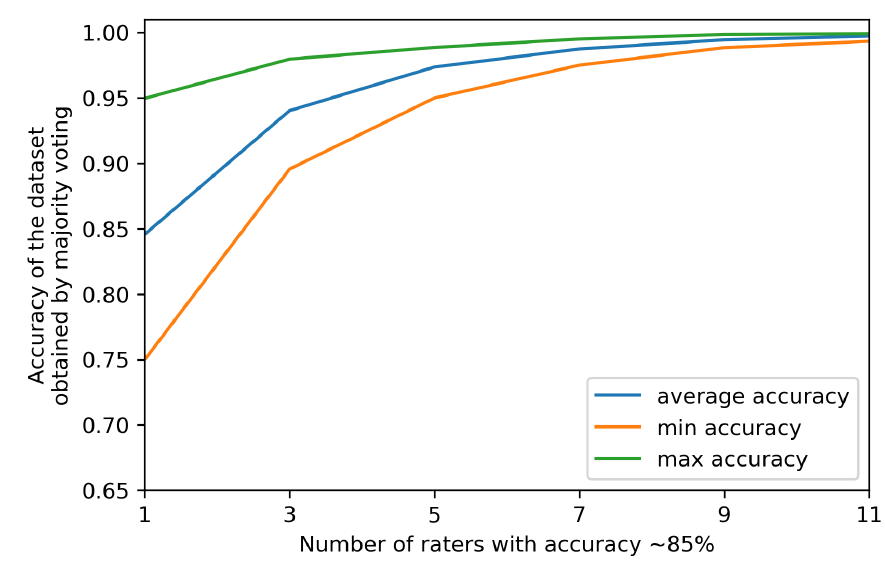
Figure 2. The figure depicts the average, minimum, and maximum accuracy of the datasets obtainable for a given number of raters, each with an average accuracy of 85% ± 1%, by simple majority voting among the raters for each case. The three estimates of accuracy were obtained by an analytical simulation, computed through random sampling from a simulated population of 100 individuals with the above-mentioned characteristics and by computing, respectively, the average, minimum, and maximum observed value among the extracted